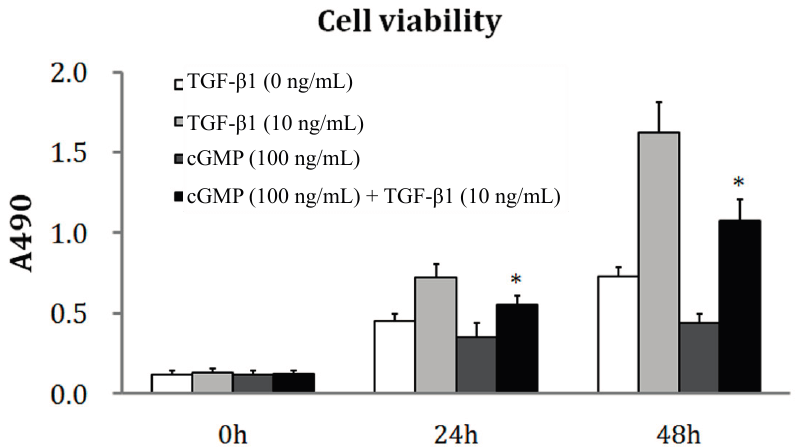
Figure 1. The effect of cGMP (cyclic guanosine monophosphate) on cellular proliferation. The OD values in MTT (3-(4,5)-dimethylthiahiazo-(z-y1)-3,5-di-phenytetrazoliumromide) assay were measured after PVEC (pulmonary vascular endothelial cell) cells were treated with fresh medium containing TGF- β 1 (0, 10 ng/mL), cGMP (100 ng/mL) and TGF- β 1 (100 ng/mL) + cGMP(10 ng/mL) for 24 and 48 h. The OD values of cells were remarkably increased after 24 and 48 h treatments with TGF- β 1. However, for the cells incubated with cGMP at 10 ng/mL and TGF- β 1 at 100 ng/mL together after 24 and 48 h, the increased OD value was inhibited by 23% and 35%, compared with those incubated with TGF- β 1 alone. * p < 0.05, vs. the group of 10 ng/mL TGF- β